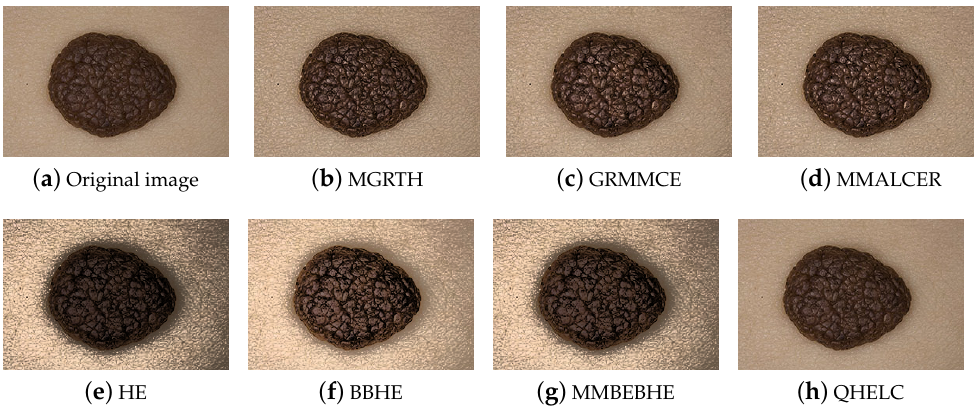
Figure 8. Malignant image. Visual results obtained by the algorithms.